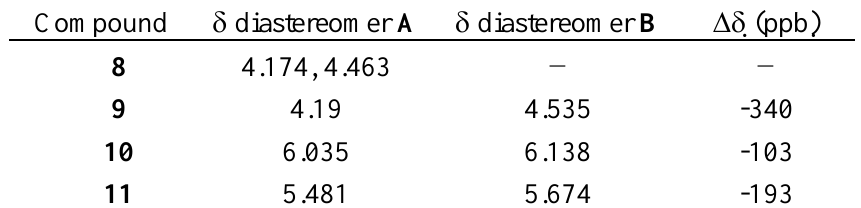
containing TMS at 25 °C. 3